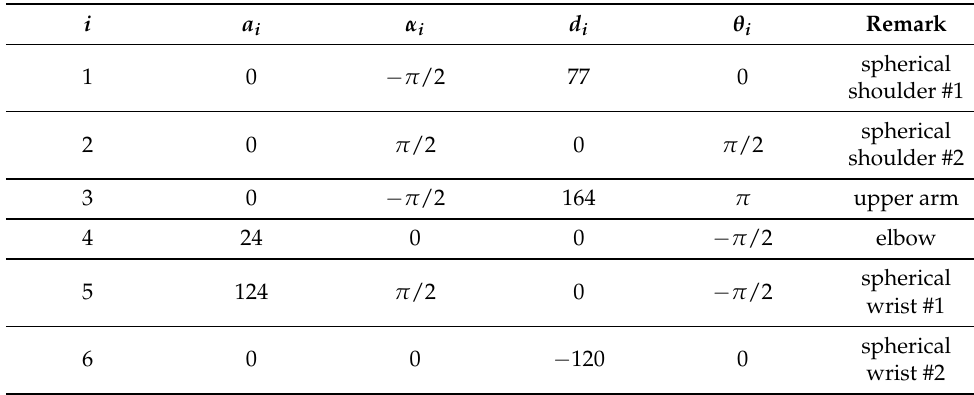
Figure 5. Our dual-arm robot manipulator. ( a ) A controller, dynamixel actuators, and Intel RealSense camera. ( b ) The dual-arm robot is ready to start solving the given geduldspiele cube. Table 2. The DH parameter for one arm of our dual-arm